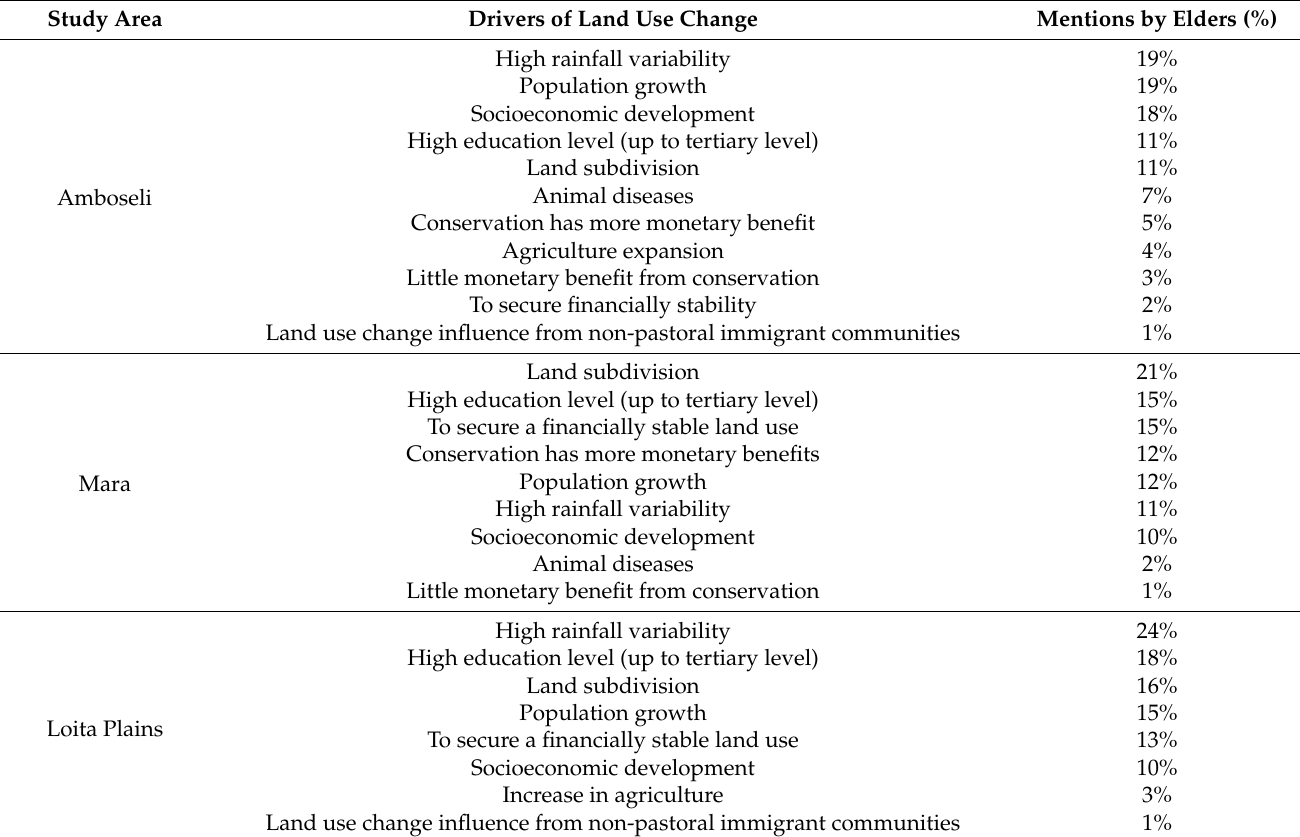
Table 3. Drivers of land use change as perceived by pastoralists from Amboseli, Mara and the Loita Plains in southern Kenyan savannas. Study Area Drivers of Land Use